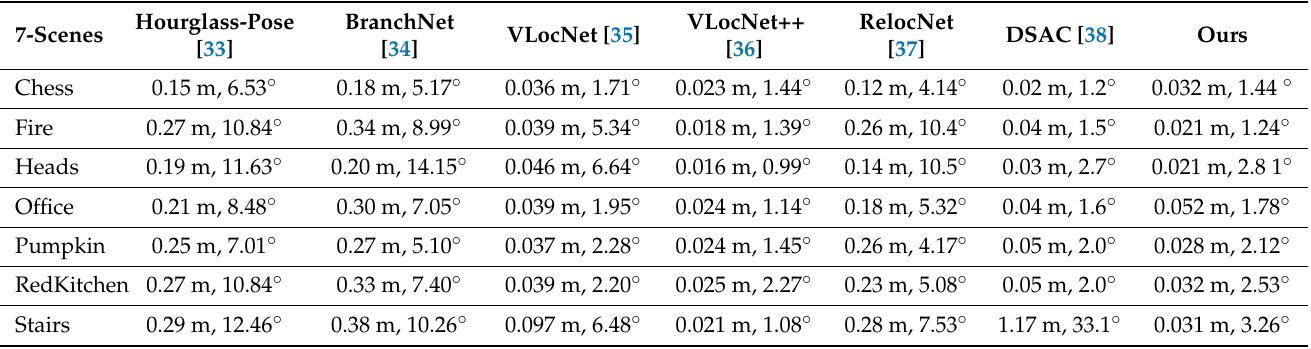
Table 3. Median translation and rotation errors of our method with different pose estimators on the 7-Scenes dataset.